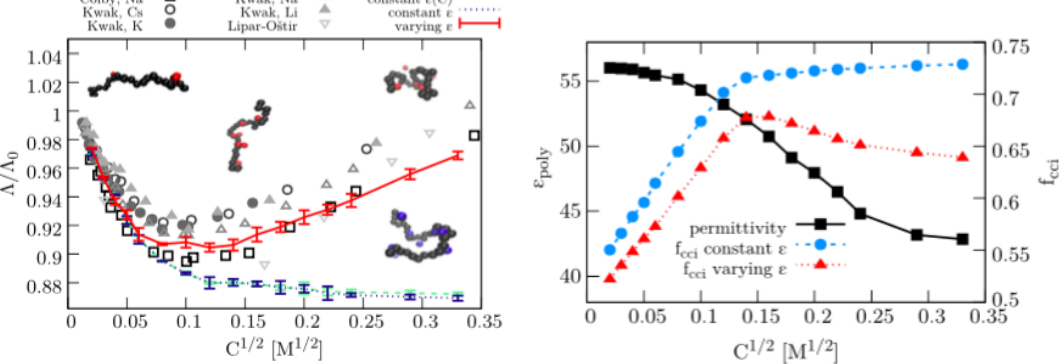
Figure 1. ( Left ) Normalized ionic conductivity Λ / Λ 0 of polyelectrolyte solutions with varying salt concentrations C 1/2 . The single dots denote the values of experimental outcomes. The straight solid red line shows the results of coarse-grained molecular dynamics simulations with a varying dielectric constant. The dashed green line highlights the corresponding results for a constant value of (cid:101) r . Snapshots of polyelectrolyte conformations for specific salt concentrations in combination with counterions are shown in the inset. ( Right ) Fraction of condensed counterions f cci around a highly charged polyelectrolyte for constant (blue circles) and varying values of the dielectric constant (cid:101) poly (red triangles). A foxed dielectric constant was set to a value of (cid:101) r = 56 whereas the resulting outcomes in terms of dielectric decrement effects are denoted as black triangles. Figure reproduced from Ref. [65]. The results for the dielectric constant (cid:101) r and the fraction of condensed counterions f ccl reveal that the dielectric constant decreases from (cid:101) r = 56 at a square-root salt concentration of C 1/2 = 0.01 M 1/2 to a minimum value of (cid:101) r = 42 at C 1/2 = 0.34 M 1/2 . In combination, a non-linear change of the normalized ionic conductivity Λ / Λ 0 can be observed at C 1/2 = 0.13 M 1/2 . The corresponding